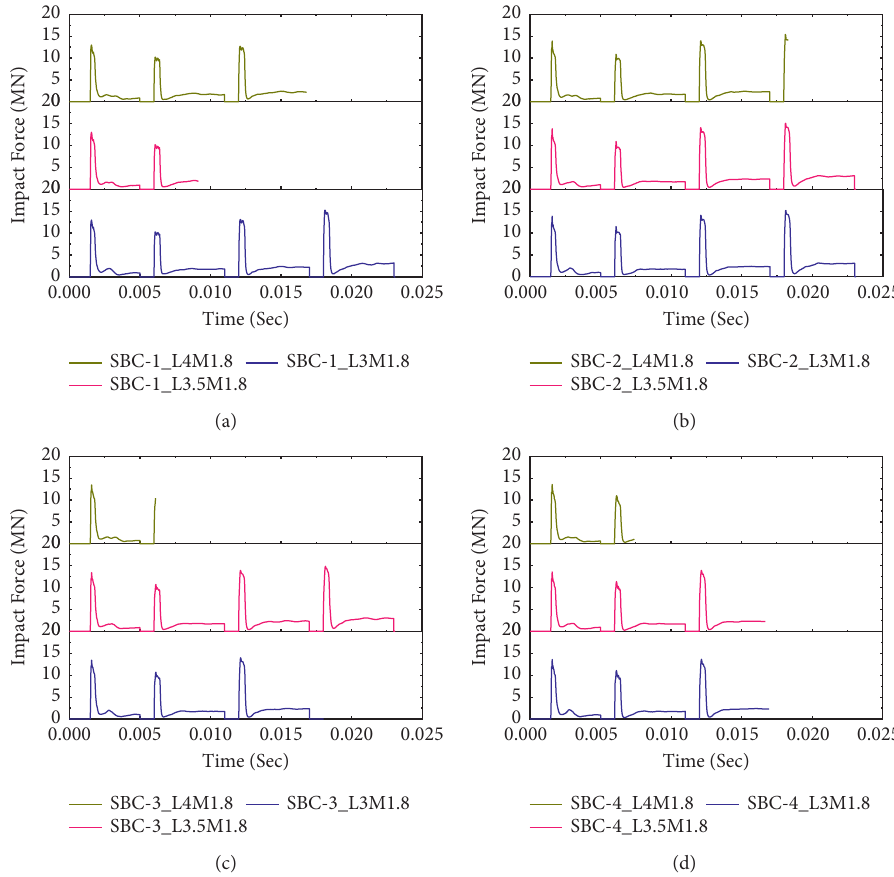
Figure 21: Influence of column height on impact capacity of CFRP confined BRC columns: (a) normal, (b) two-bundle, (c) three-bundle, and (d) four-bundle reinforcement